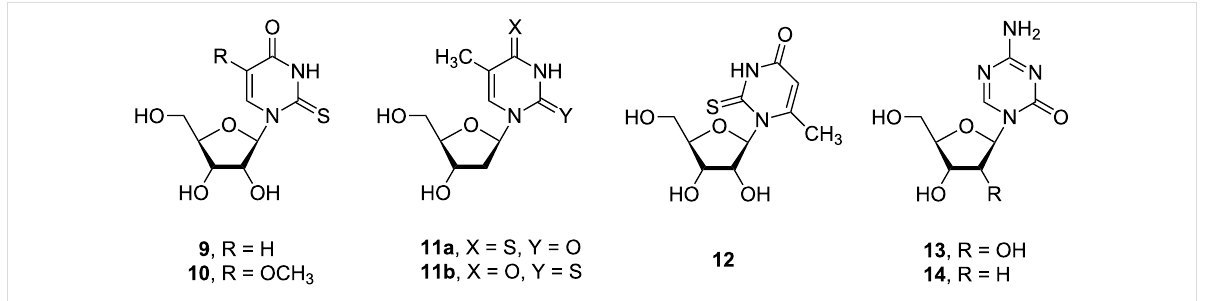
Figure 5: Structures of 2-thiopyrimidine( 9 – 12 ) and 5-azacytidine ( 13 and 14 )